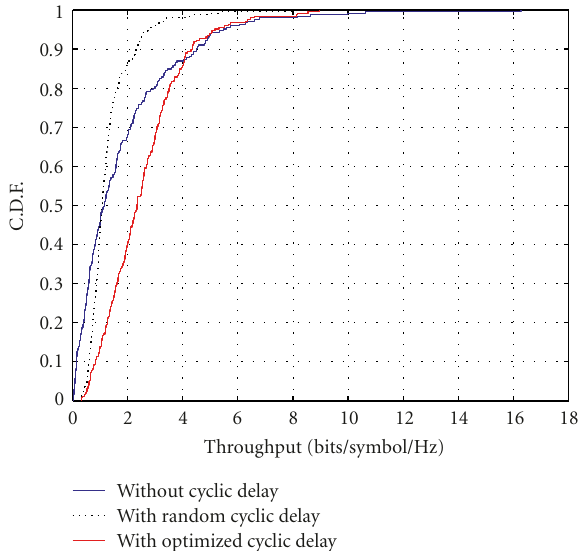
Figure 16: Cumulative distribution function of the received SINR for the two optimized algorithms on an urban environment with a cell radius of 500 m.